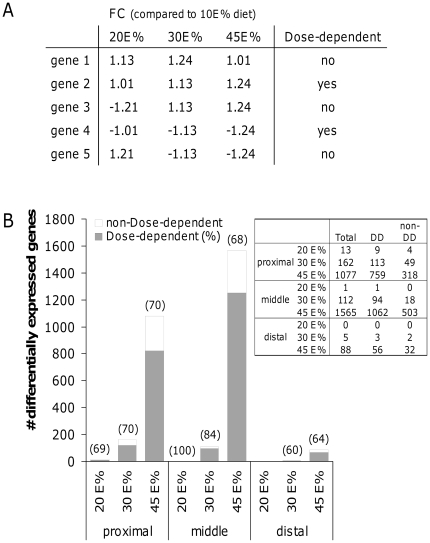
Fat-dose dependent regulation of gene expression in the small intestine.By applying specific inclusion criteria (A), fat-dose dependent regulation of gene expression was determined for the proximal, middle and distal part of the small intestine (B). In brackets, the percentages of fat-dose dependently changed genes are shown as part of total differentially expressed genes on the 20E%, 30E% and 45E% fat diets compared to the control 10E% fat diet. FC: fold changes, DD: dose-dependent, non-DD: non-dose-dependent.